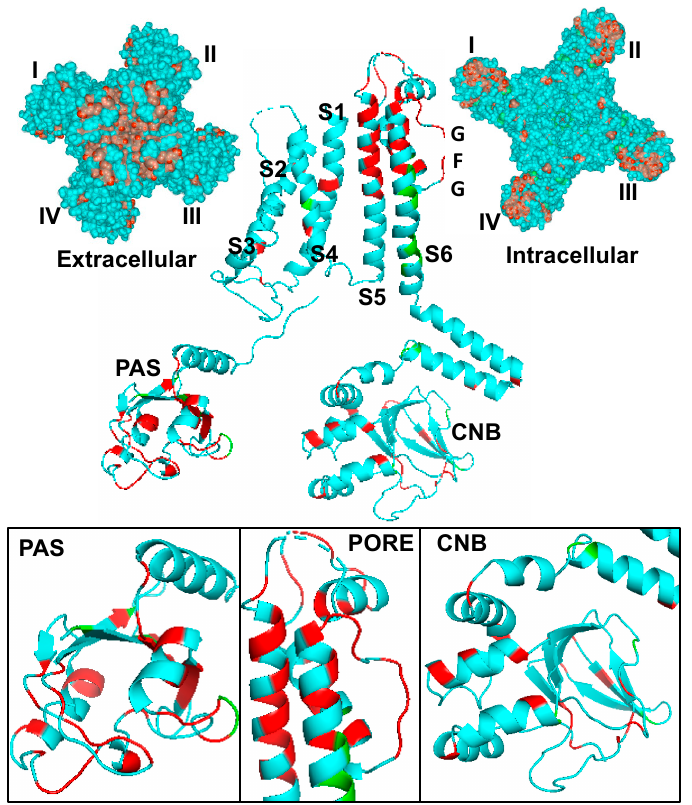
Figure 2. A CryoEM structure of Kv11.1a channel as viewed from the extracellular and intracellular side of the membrane (top left and right, each Kv11.1a α -subunit is denoted I-IV). A side-view of an individual Kv11.1a α -subunit highlighting the selectivity filter (G-F-G) and the secondary structures of the PAS, PORE, and CNB domain (middle and bottom). The location of LQT2 missense mutations that have been tested and disrupt Kv11.1a channel trafficking is shown in red. Green denotes the location of LQT2 missense mutations that have been tested and do not disrupt Kv11.1a trafficking.